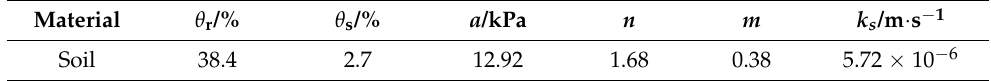
Table 2. Mechanical properties of slope material.